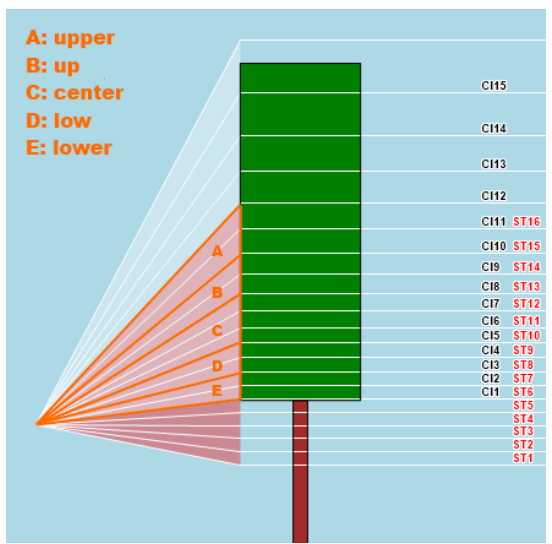
Figure 3. MECS ‐ VINE ® sensing geometry (front view): Surface Temperature ( ST ) sectors (1~16) in red; Canopy Index ( CI ) sectors (1~15) in white with black labels; ST and CI overlapping area is sub ‐ divided into 5 macro ‐ sectors for CI ‐ Normalized ST calculation (macro ‐ sectors A, B, C, D, E in orange color).